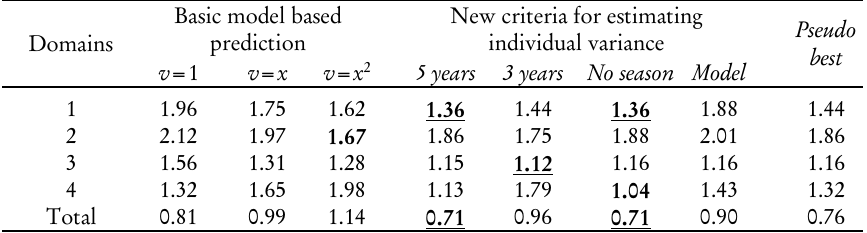
Comparison among MAPEs obtained through the use of the GREG estimator and different criteria for model unit variance estimation Mean of 4 quarters – Real data referred to 2010 – Estimates with post-stratification New criteria for Domains